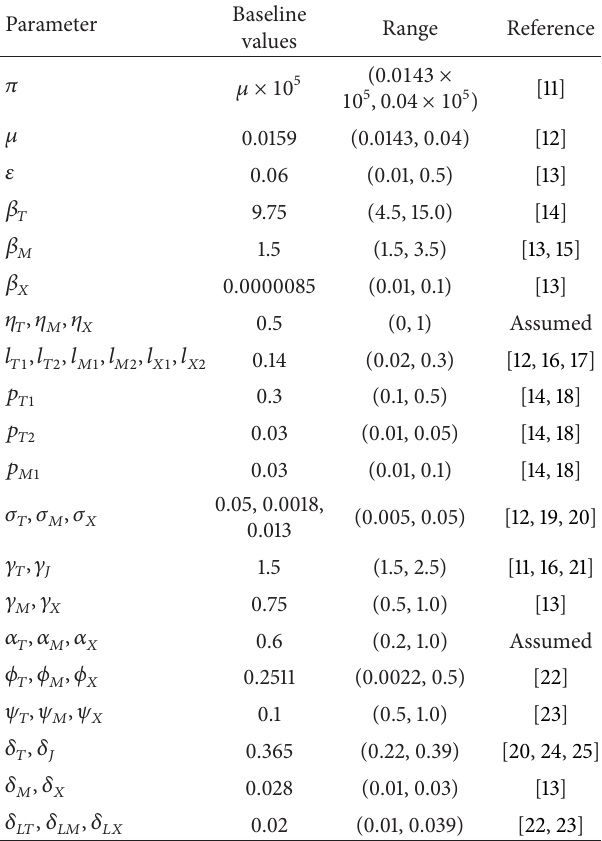
Table 2: Values of the parameters of the model (2).